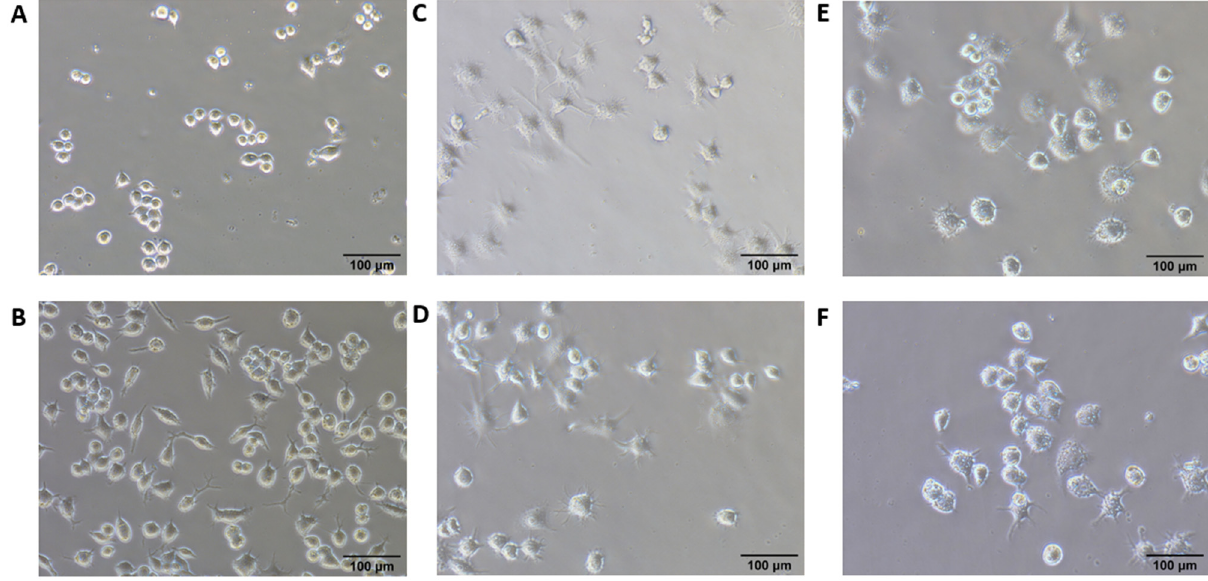
Figure 3. 200X brightfield images of RAW 264.7 cells. RAW264.7 cells were treated with ( A ) complete medium only, ( B ) empty NE, ( C ) free R848, ( D ) SD-101, ( E ) R848 NE, and ( F ) R848 NE with SD-101 for 12 h. R848 was treated at 50 µM individually, in emulsion, or in combination. SD-101 was treated at 300 nM individually or in combination.